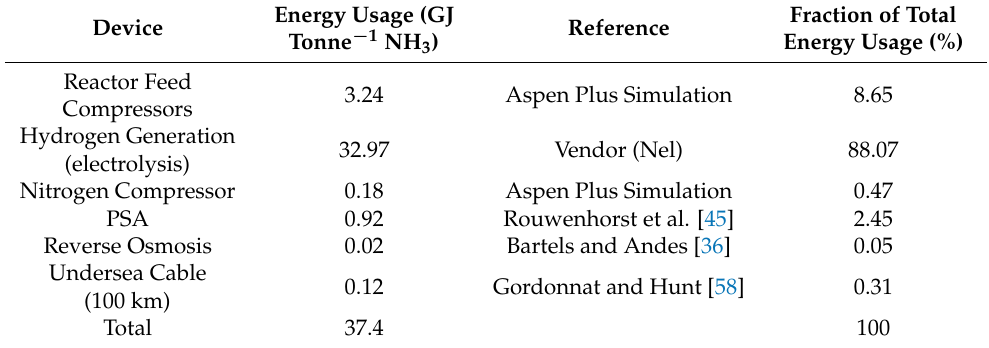
Table 4. Power consumption of each component in P2A system.